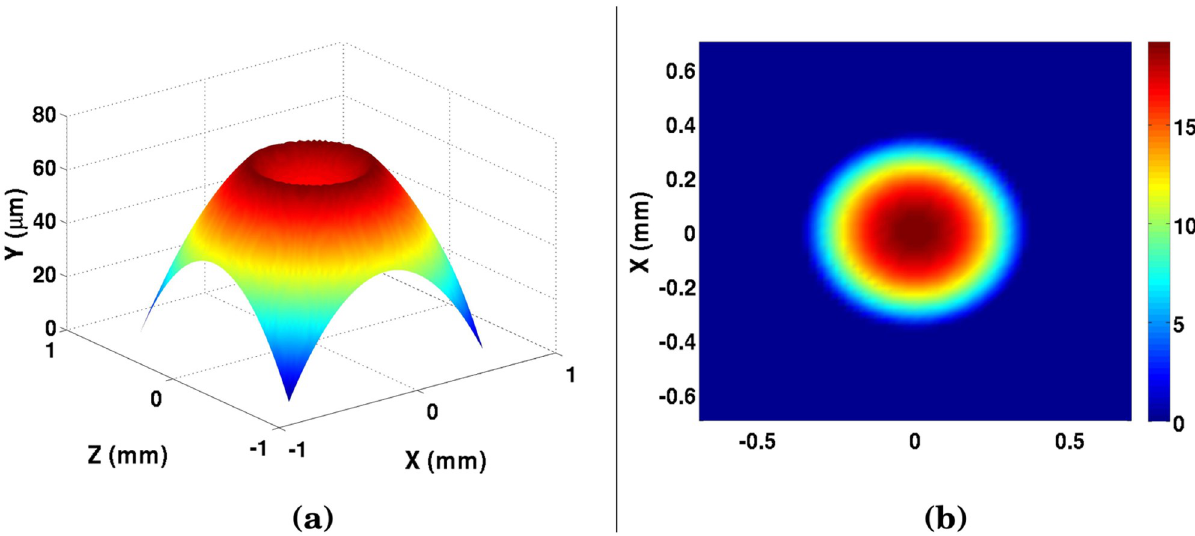
Fig 7. Numerical results of wear after 1 hour of sliding contact at a bulk temperature of 59˚C and a load of 391 Newtons, both (a) with and (b) without the ball bearing profile. Colorbarin (b) represents wear in μ m.